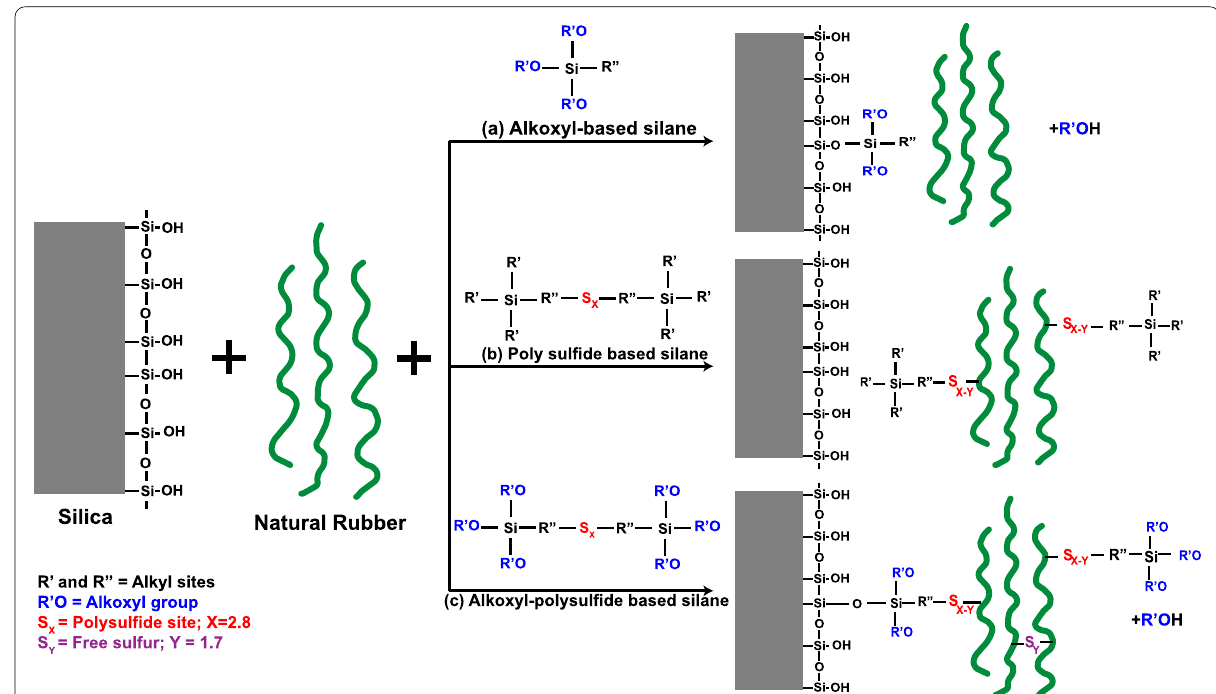
Fig. 5 The reinforcement mechanism of silica‑filled NR composites in the presence of silane with different functionalities [42]. Redrawn with permission from John Wiley and